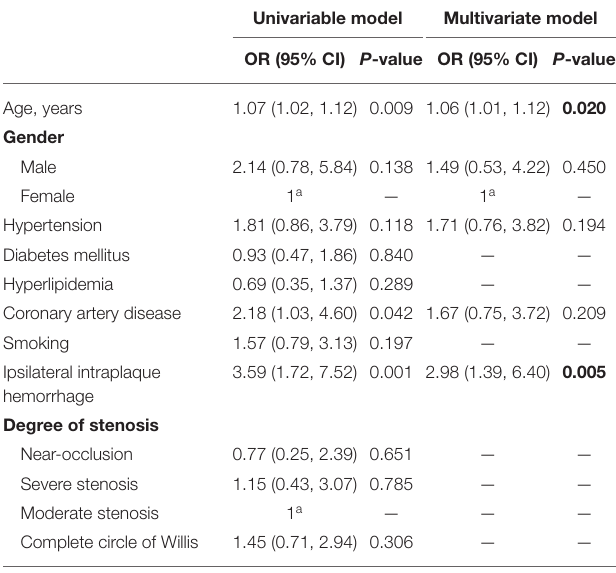
TABLE 2 | Multivariable logistic regression analysis for factors associated with cerebral small vessel disease burden.